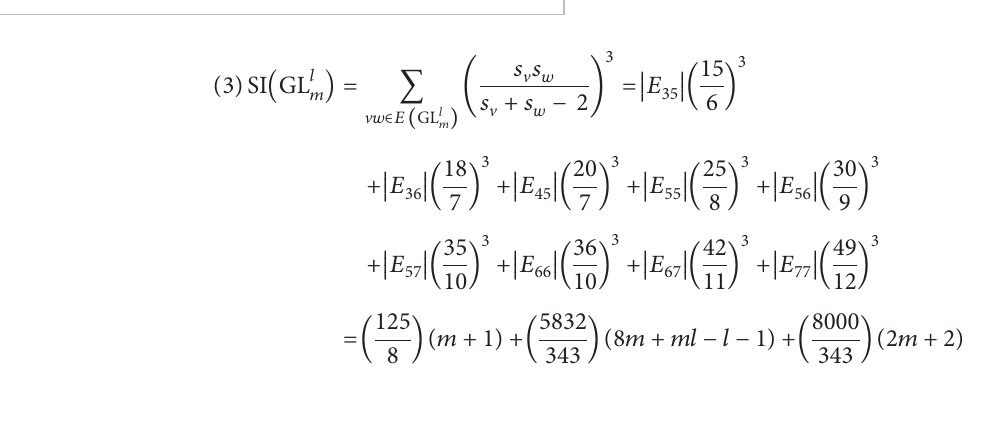
Figure 8: Comparison of CL l Zagreb